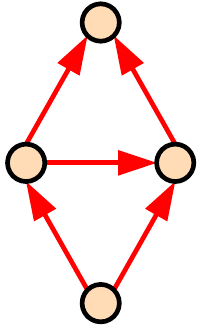
Figure 8. Array-digraph D .